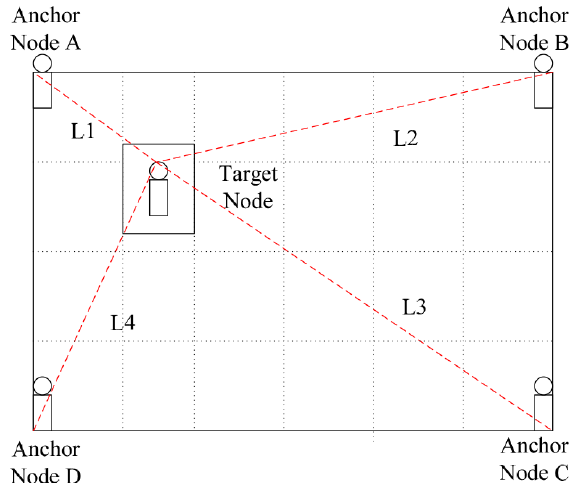
Figure 3. The principle of RSSI